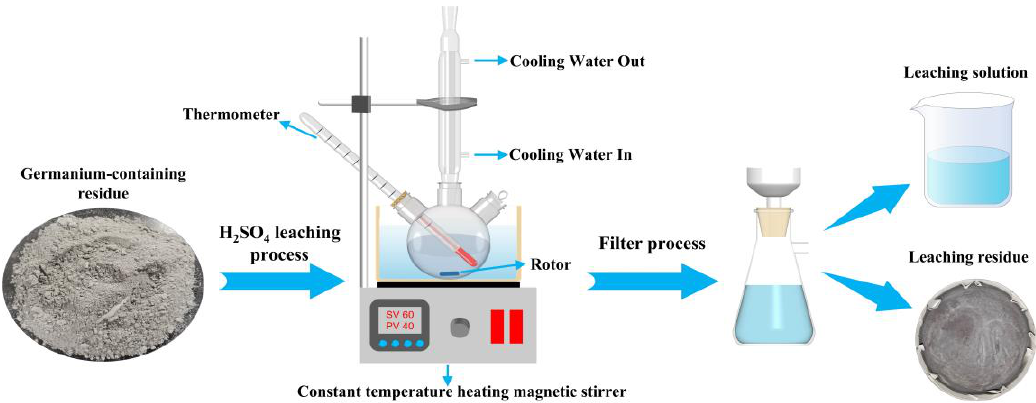
Figure 1. Schematic diagram of the leaching experimental